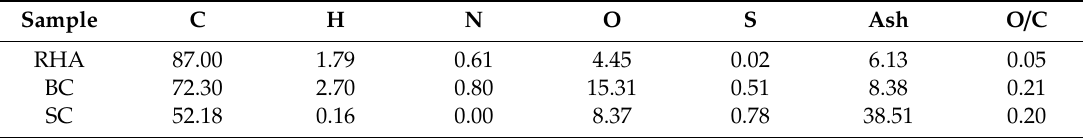
Table 3. Main elements and their relative contents (%) in the carbon materials